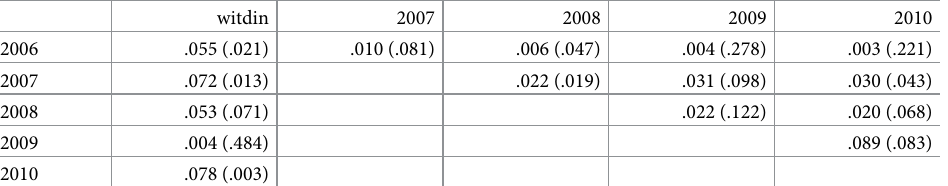
Table 4. Correlation coefficients year by year between educational choices and country of origin. Effect sizes (and p -values are given year by year within classes and in pairwise comparisons between years between classes.